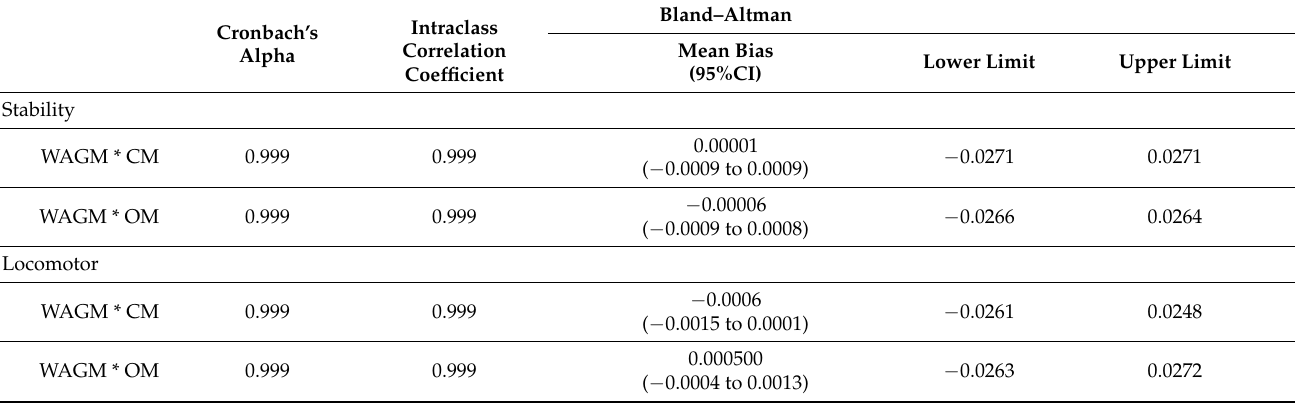
Figure 1. Bland–Altman graphs representing differences between the predicted models and the Weighted Age Group Model (WAGM) reference values for the MCA sub-scales, according to the percentile positions of the reference values of the WAGM vs. the mean of the two measurements, with limits of agreement and respective 95% confidence intervals. Table 2. Reliability and Bland–Altman agreement analysis (mean bias and 95% limits of agreement) between the MCA sub-scale scores. Comparisons of the Configural Model and the Overall Model procedures with the Weighted Age Group Model.